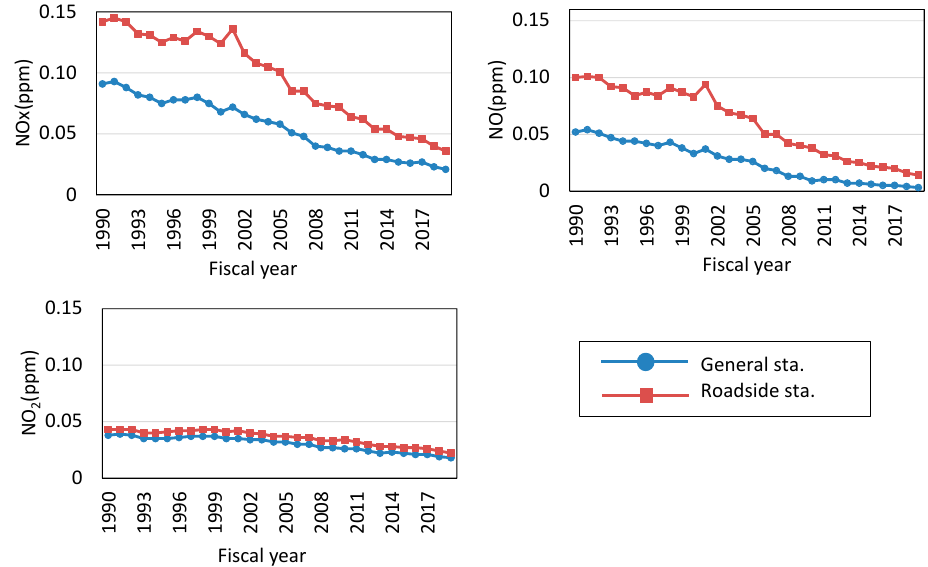
Figure 19. Trend in NOx, NO, and NO 2 over time at night during the cold season. NOx, NO, and NO 2 : annual averages of hourly NOx, NO, and NO 2 at nine General sta. and nine Roadside sta. in the cold season.